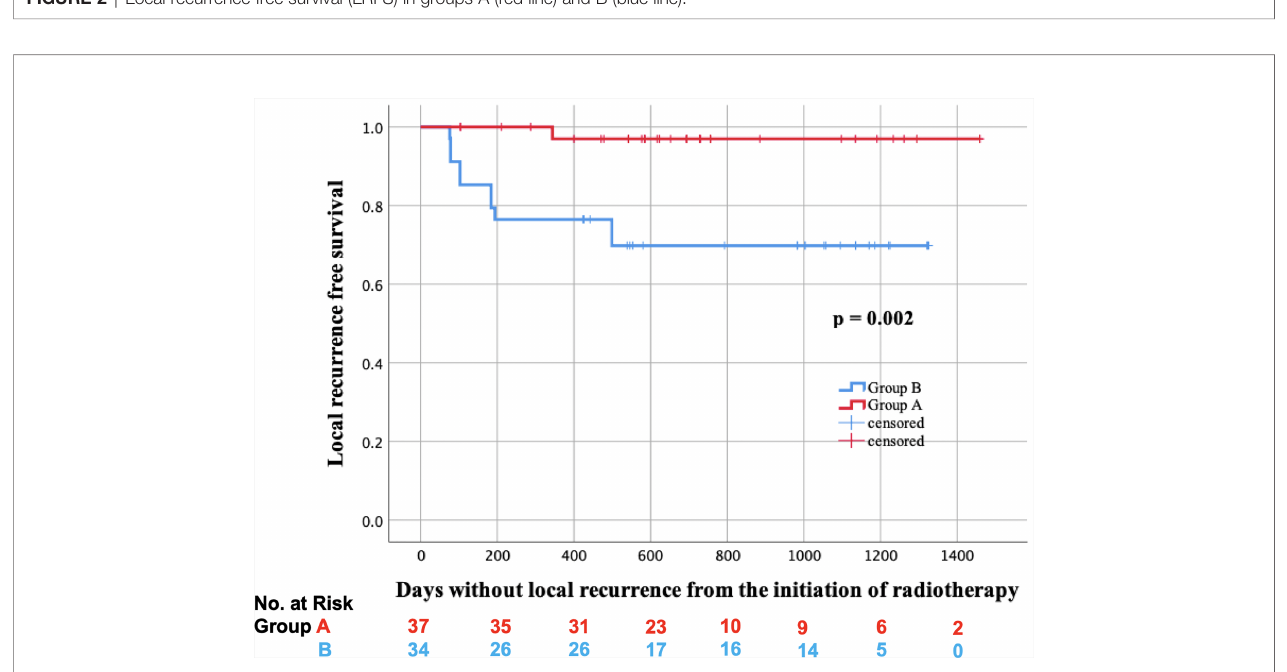
FIGURE 2 | Local recurrence free survival (LRFS) in groups A (red line) and B (blue line).